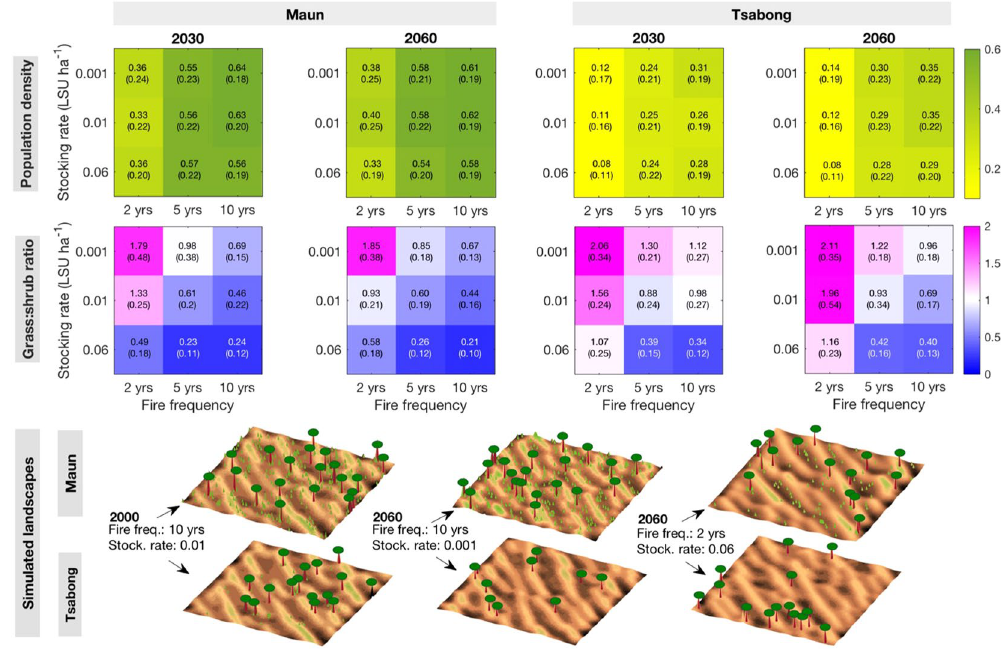
Figure 5. Matrices of population density and grass:shrub ratios at Maun and Tsabong under RCP 4.5, for 2030 and 2060, with three different fire frequencies (low: once every 10 years, medium: once every 5 years, high: once every 2 years) combined with three different grazing pressures (low stocking rate: 0.001 LSU ha − 1 , medium: 0.01 LSU ha − 1 , high: 0.06 LSU ha − 1 ) imposed on the landscape (see Methods). Values are given in each matrix square (standard deviation in brackets), with colour scaling. Three-dimensional examples of simulated landscapes in 2000 and 2060 are displayed for comparison purposes (trees shown as trunks with distinct crowns, shrubs/ grasses shown as green patches). Values above grass:shrub unity represent grass dominance, and values below unity represent shrub dominance. Model was run 3 times per fire/grazing scenario at both sites from the year 1960, using projected precipitation data with random variation based on 5-year moving averages of seasonal standard deviations. 20 wind events occurred every 3 months, over a grid of 150 × 150 cells. The domain was randomly initiated with vegetation cover and species proportions observed at the end of an equilibrium run for 1960. Landscape characteristics in the matrices were calculated as means over the 10 years around both chosen